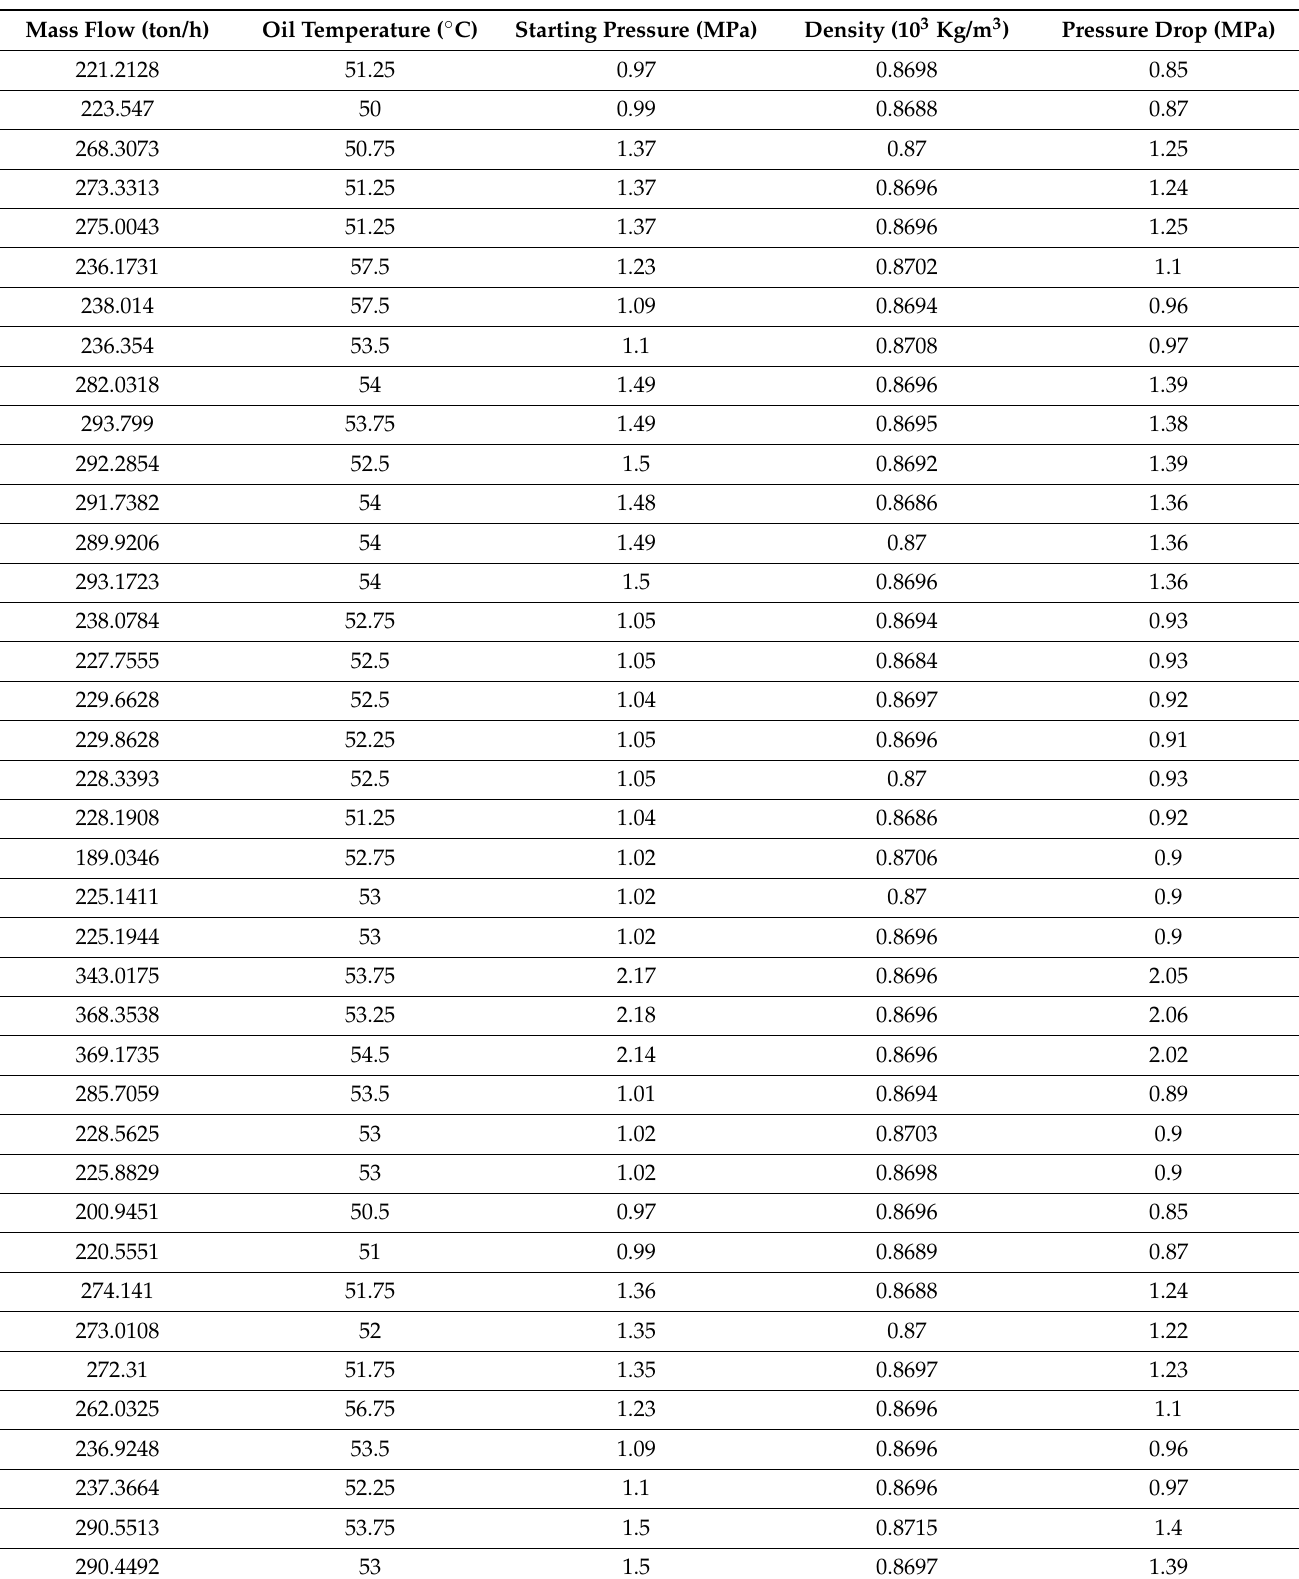
Table 1. Data table of the oil